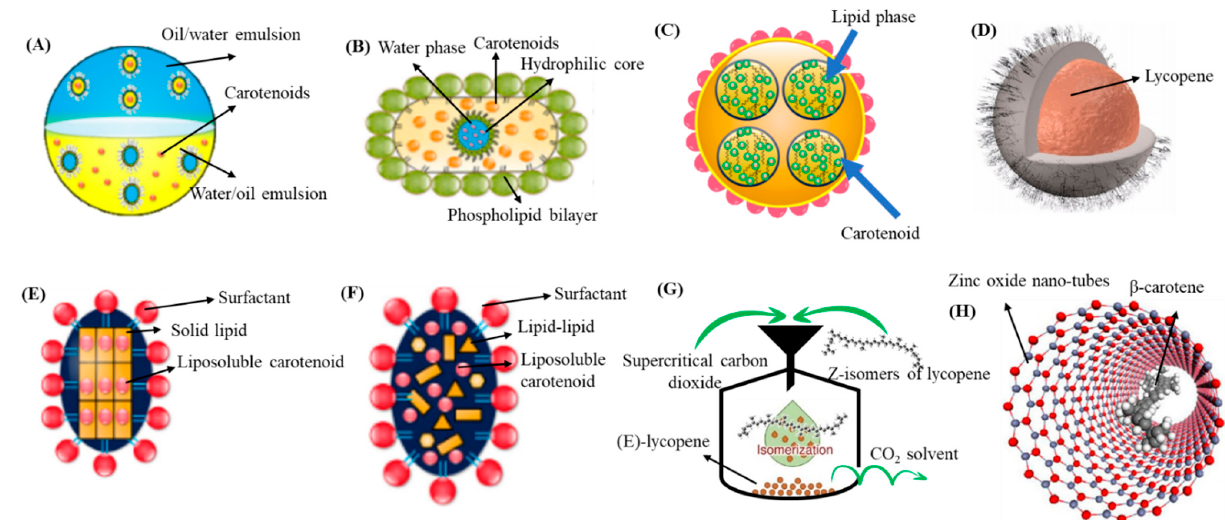
Figure 3. Schematic representation of different nanocarriers for encapsulation of carotenoids. Nanoemulsion ( A ), nanoliposomes ( B ), nanohydrogels ( C ), polymeric/biopolymeric ( D ), solid lipid NPs ( E ), nanostructured lipid carriers ( F ), supercritical fluid-based NPs ( G ) and metal/metal oxide-based NPs ( H ). NPs = nanoparticles. Adapted with permission from Kodama, et al. [75], Monteiro, et al. [76], Rehman, et al. [9], and Vasconcelos, et al. [45].